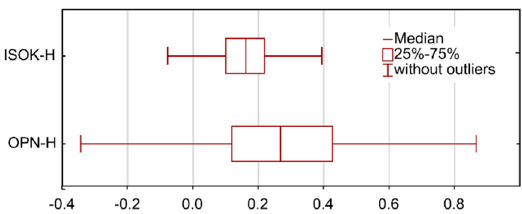
Figure 9. Box plot based on differences between the ONP and ISOK DTMs and measured cross-section profiles—H (ground truth). Table 3. Statistics based on differences between the ONP and ISOK DTMs and measured cross-section profiles—H (ground truth).